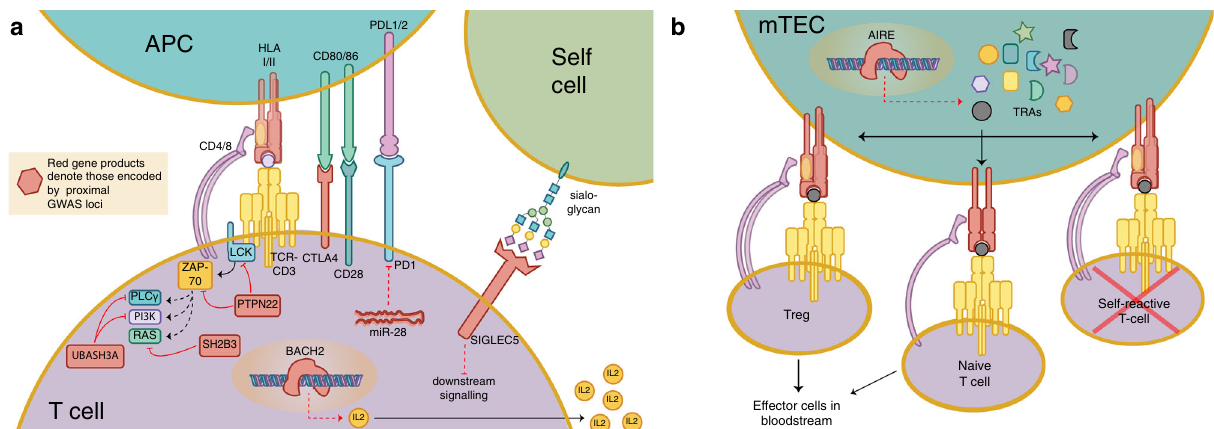
Fig. 6 T-cell regulation and AAD GWAS associated regions. a Graphic representation of selected aspects of T-cell regulation, with gene products implicated by GWAS association proximity in red (antigen-presenting cell, APC). b AIRE activity in medullary thymic epithelial cell (mTEC), promoting expression of tissue-restricted antigens (TRAs) for the education of T